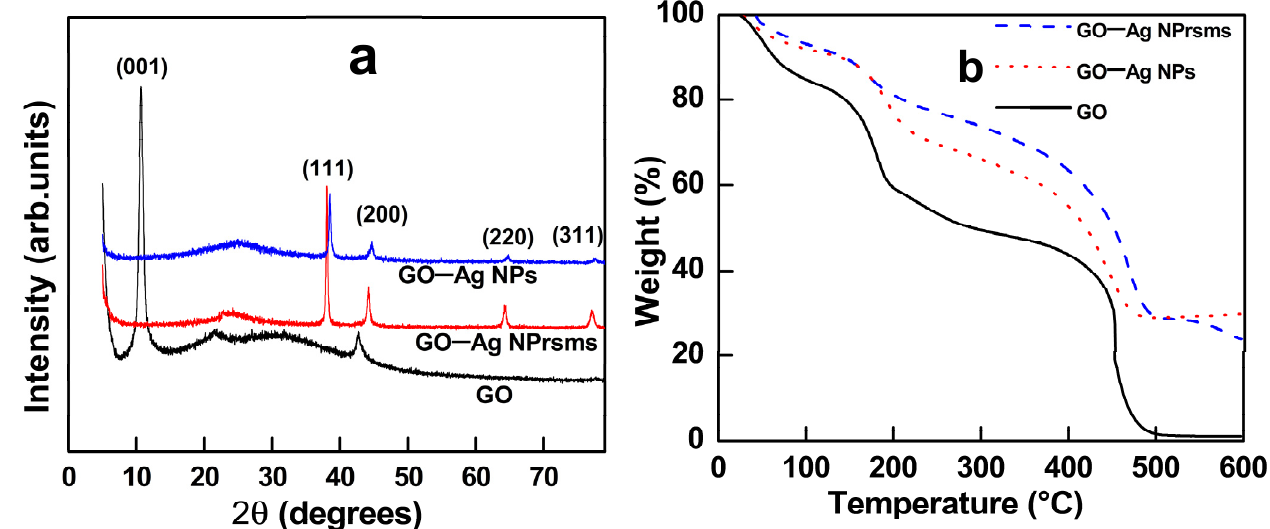
Figure 4. XRD profiles ( a ) and TGA thermograms ( b ) of GO, GO–Ag NPs, and GO–Ag NPrsms.